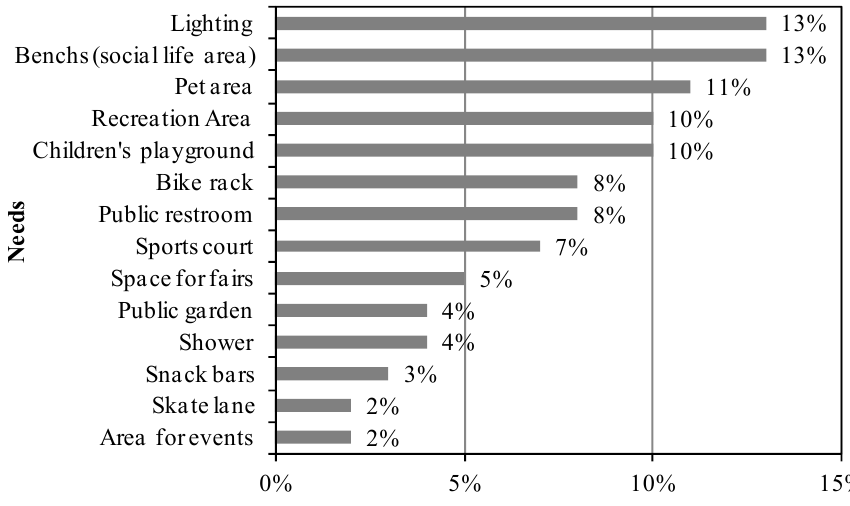
Figure 6. Results obtained by applying the questionnaire.